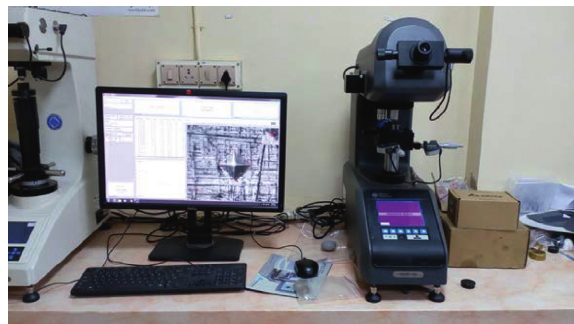
Figure 9: Microhardness